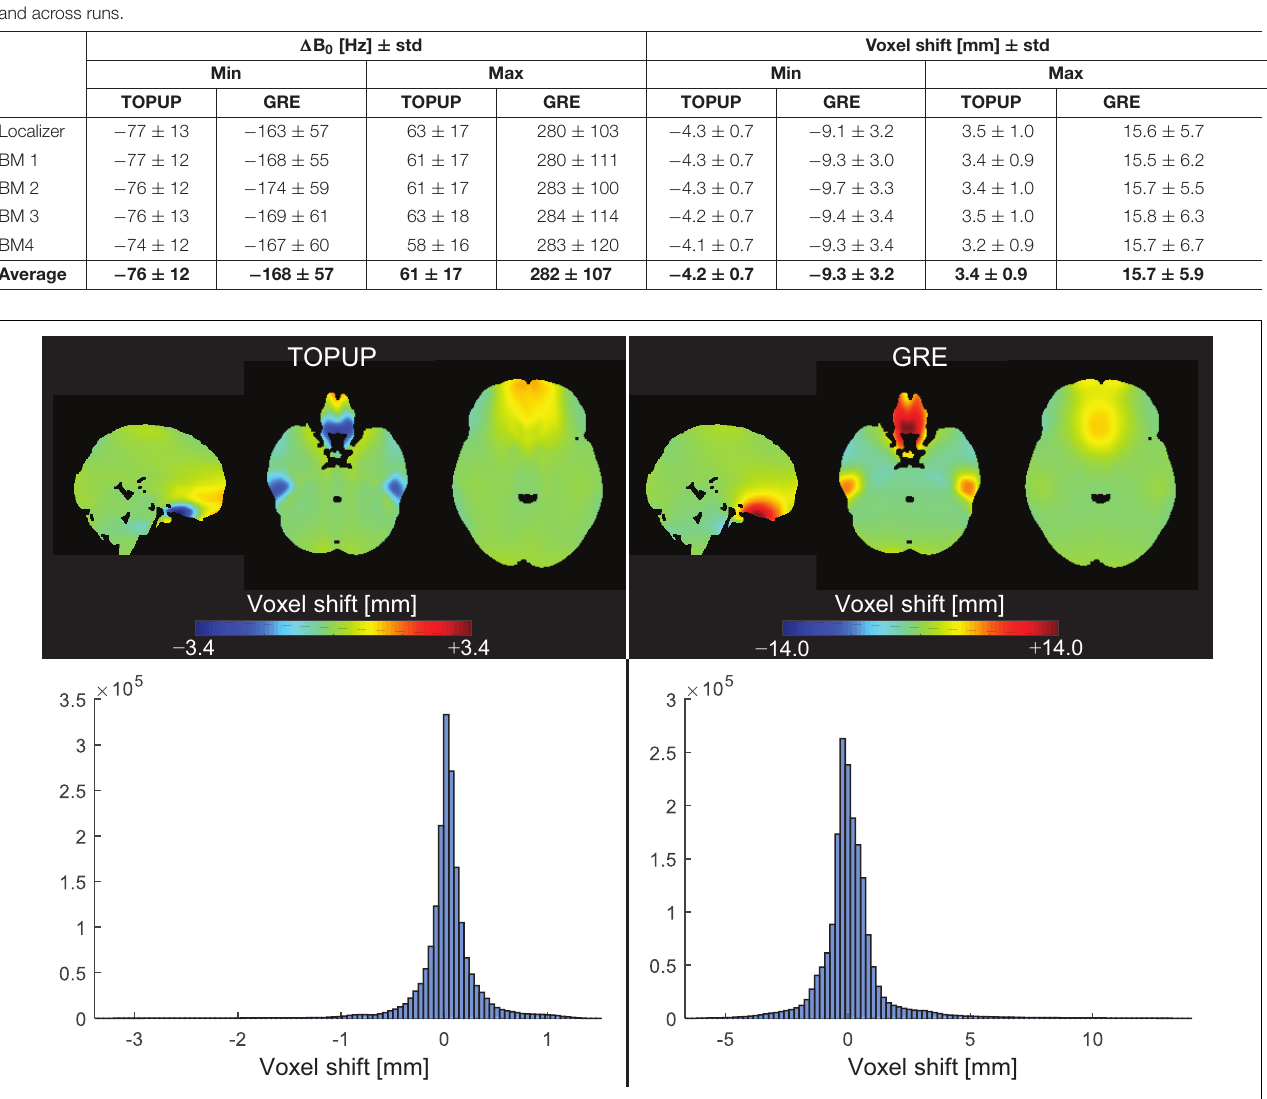
FIGURE 3 | (Top) Voxel shift maps (VSMs), in the MNI space, averaged across participants and runs, for the (left) TOPUP and (right) GRE correction approaches. The scale was set to be symmetric for easing the interpretation of the maps (where green colors always represent no shifts). (Bottom) Histograms of the associated VSMs.